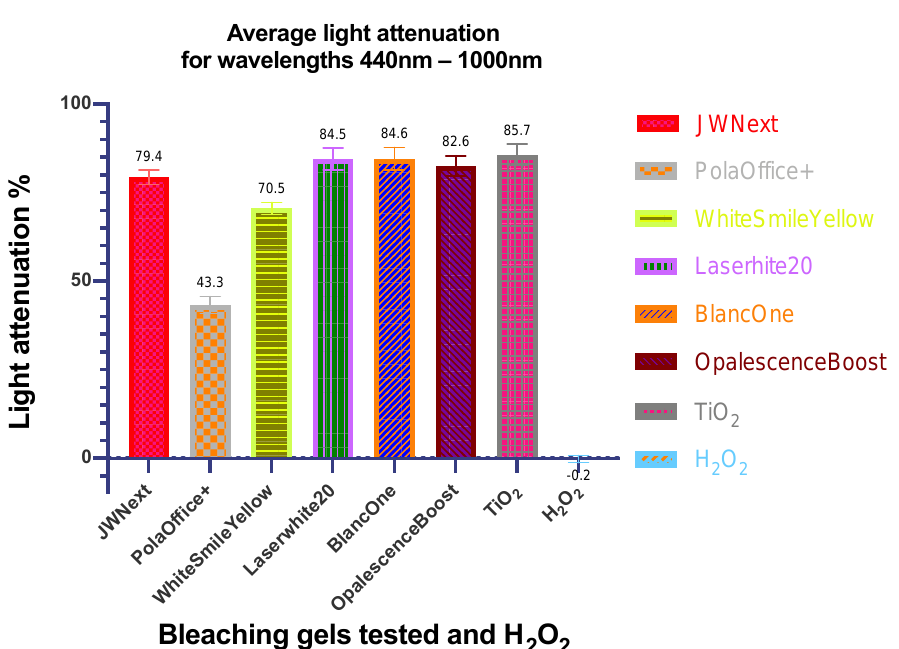
Figure 5. Bar diagram showing the mean ± SD values for light attenuations observed across all wavelengths tested by the bleaching gel products and 30% ( w / w ) H 2 O 2 control evaluated. It was clear that JW Next, Laserwhite20, BlancOne, OpalescenceBoost and TiO 2 had notable interactions with light, while the WhitesmileYellow product exhibited a slight difference. PolaOffice+ presented the lowest attenuation percentage from all gels, and light could pass through H 2 O 2 without